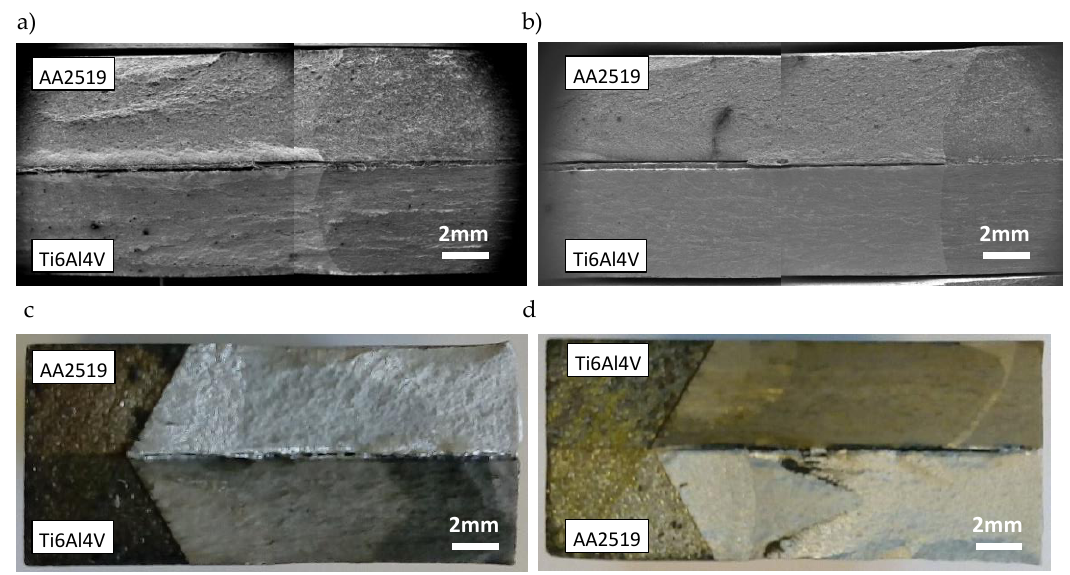
Figure 7. Delamination cracking in the weld area: ( a ) CT specimen-293 K, ( b ) CT specimen-77 K, ( c ) SENB specimen-293 K, and ( d ) SENB specimen-223 K.